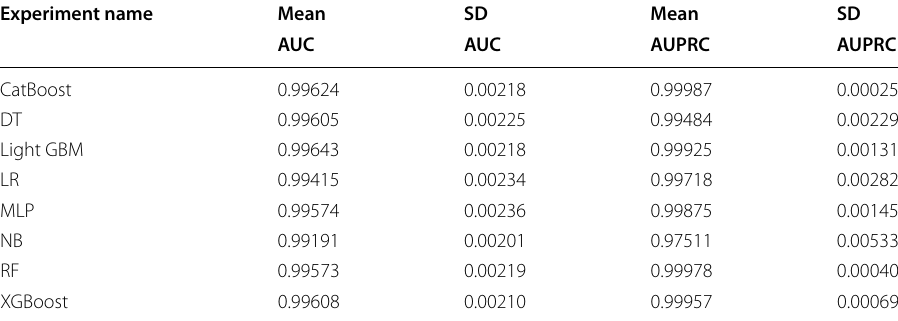
Table 32 Classification results for the keylogging dataset no sampling default hyperparameter values experiments; mean and standard deviations of AUC and AUPRC, (10 iterations of 5-fold cross-